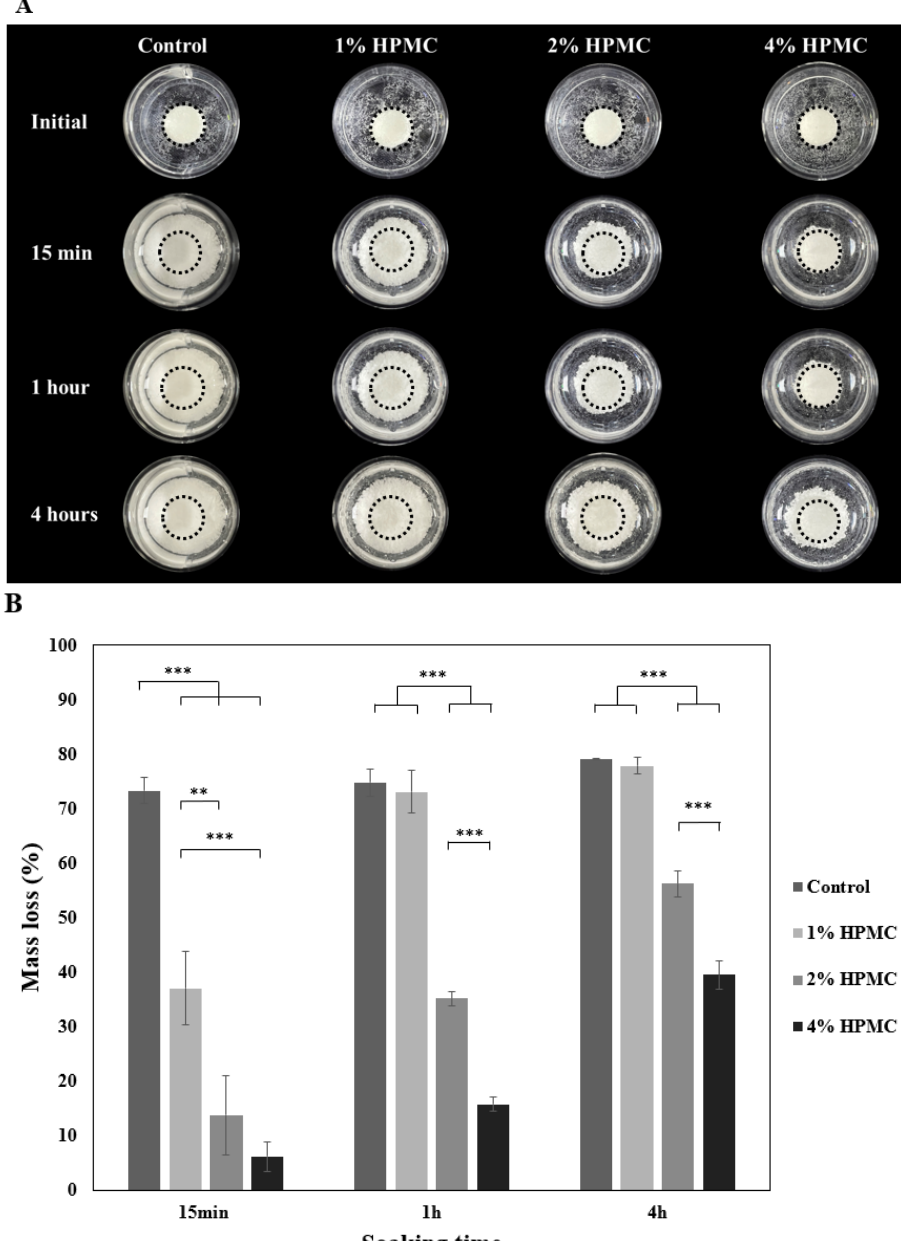
Figure 2. Washout resistance test. ( A ) Anti-washout optical images of premixed putty with different HPMC mass ratios in SBF after being soaked for different periods. ( B ) Mass loss of premixed putty containing HPMC with different mass ratios in SBF after being soaked for 15 min, 1 h, and 4 h. Dotted circles indicate the 6 mm diameter of the main body premixed putty, and outer circles indicate the disintegrated particles. Error bars denote the mean ± SD for n = 3. ** and *** indicate p < 0.01 and p < 0.001, respectively.